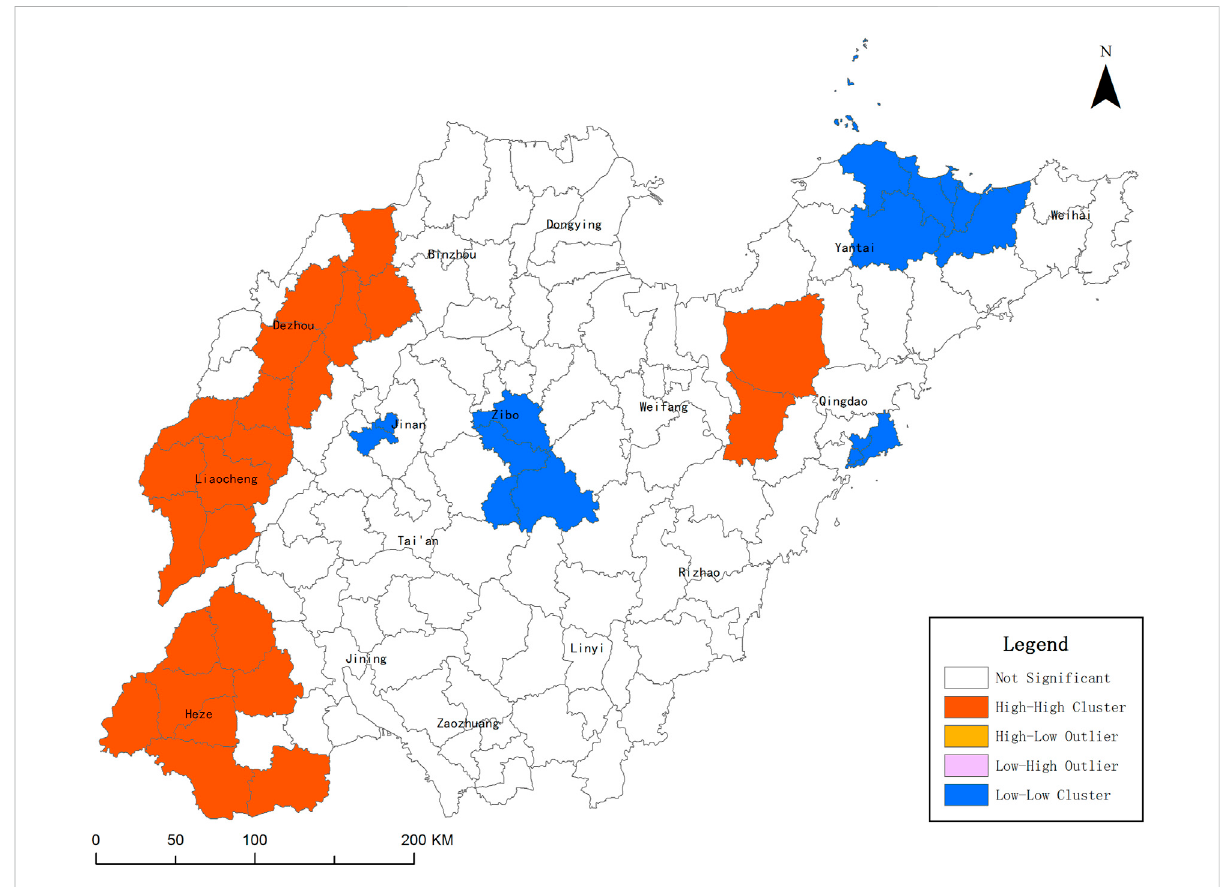
FIGURE 6 Spatial agglomeration and distribution of grain